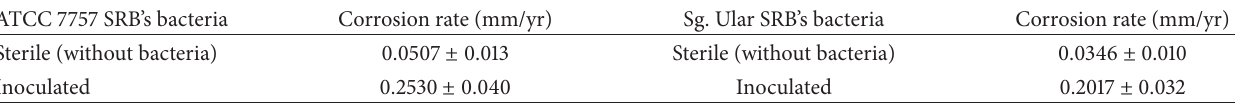
Table 1: Comparison of corrosion rate for ATCC 7757 and isolated SRB (Sg. Ular) inoculated at 37 ∘ C for 30 days.